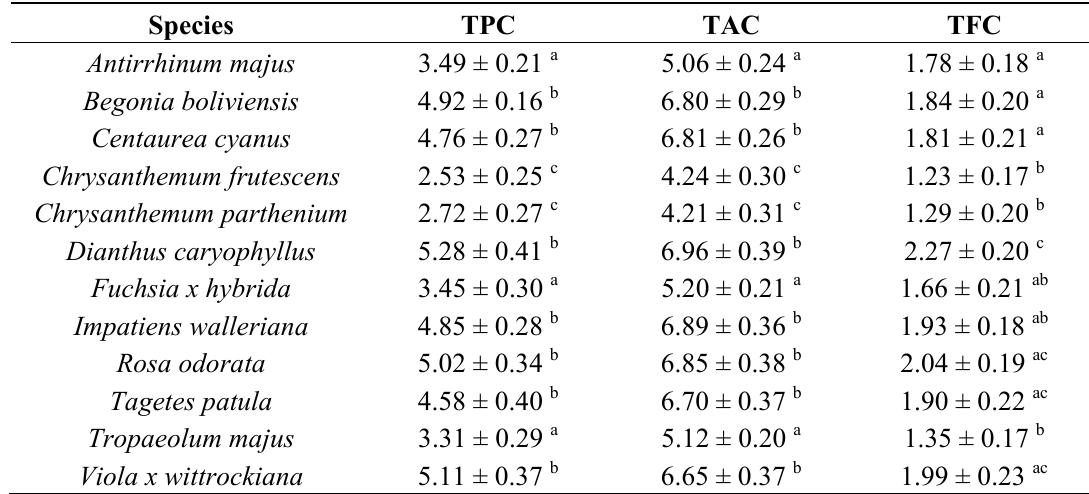
Table 1. Total phenolic content (TPC) (g of gallic acid/kg of FM), total antioxidant capacity (TAC) (g of ascorbic acid equivalents/kg of FM) and total flavonoid content (TFC) (g of rutin/kg of FM) in 12 species of edible flowers, n = 10.